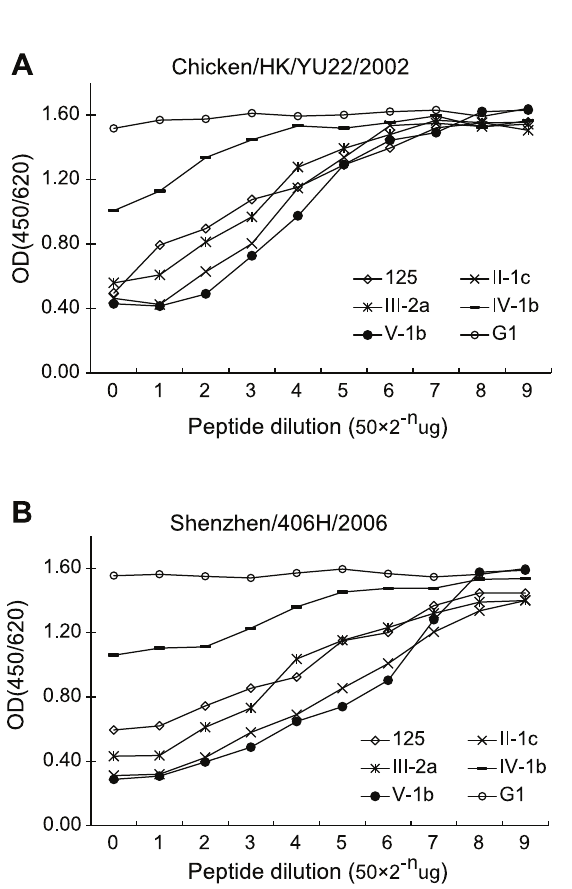
Figure 2. Titration of synthetic 12mer peptides. Serially diluted aliquots containing indicated amounts of synthetic peptide or HBcAg synthetic peptide (G1) were allowed to react with 8H5. The residual antibody available for virus binding with 2 strains of H5N1 was determined by ELISA. 8H5 blocking activity of peptides is expressed as blocking dose, defined as the amount of peptide that reduces 8H5 binding by 50%.